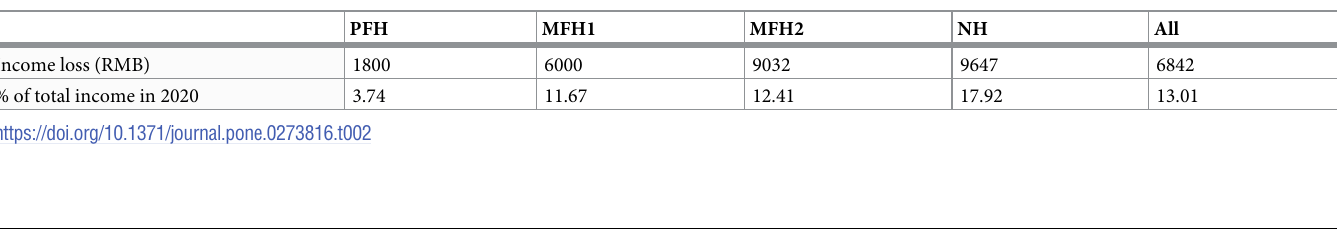
(Table 2). The income loss for PFH is the lowest. Based on our in-depth interviews, the coinci- dence of the pandemic outbreak period and the slack farming season (from the end of January to mid-March for growing citrus and paddy) determined the weak intensity of income impacts for PFH. The marketing of navel orange in the pandemic outbreak period (late winter and early spring) came to the end and the spring orchard management did not start during the out- break period. Thus, most sampled PFH (80%) have reported that the epidemic has nearly not affected their agricultural production. But 20% of sampled PFH with a lot of orange stocks have suffered from 10–16% of income loss owing to over-supply and lower farm gate prices of fruits resulting from COVID-19 restrictions on the movement of traders from outside the county and transportation interruption. In a word, along with increasing proportion of non- farm income, the absolute value and relative proportion of household income loss are all increasing.